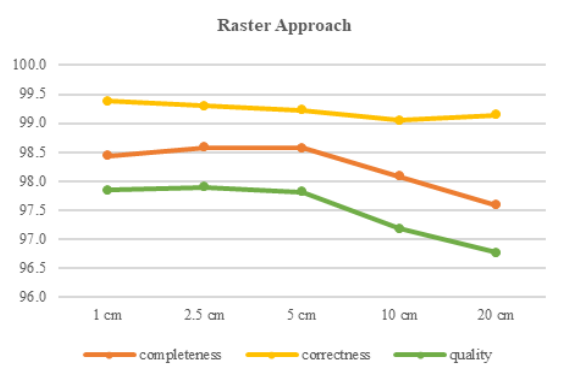
Figure 8. The quality measures of the extracted building outlines using the raster approach for 5 different point cloud densities: 1 cm, 2.5 cm, 5 cm, 10 cm, and 20